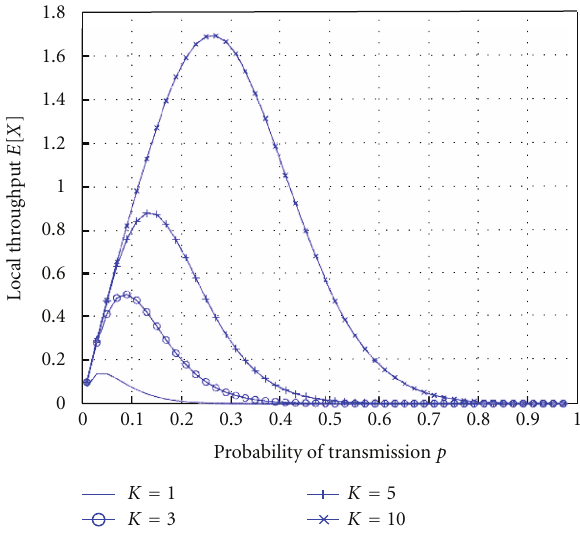
Figure 1: Local throughput in packets/timeslot for the simple model of